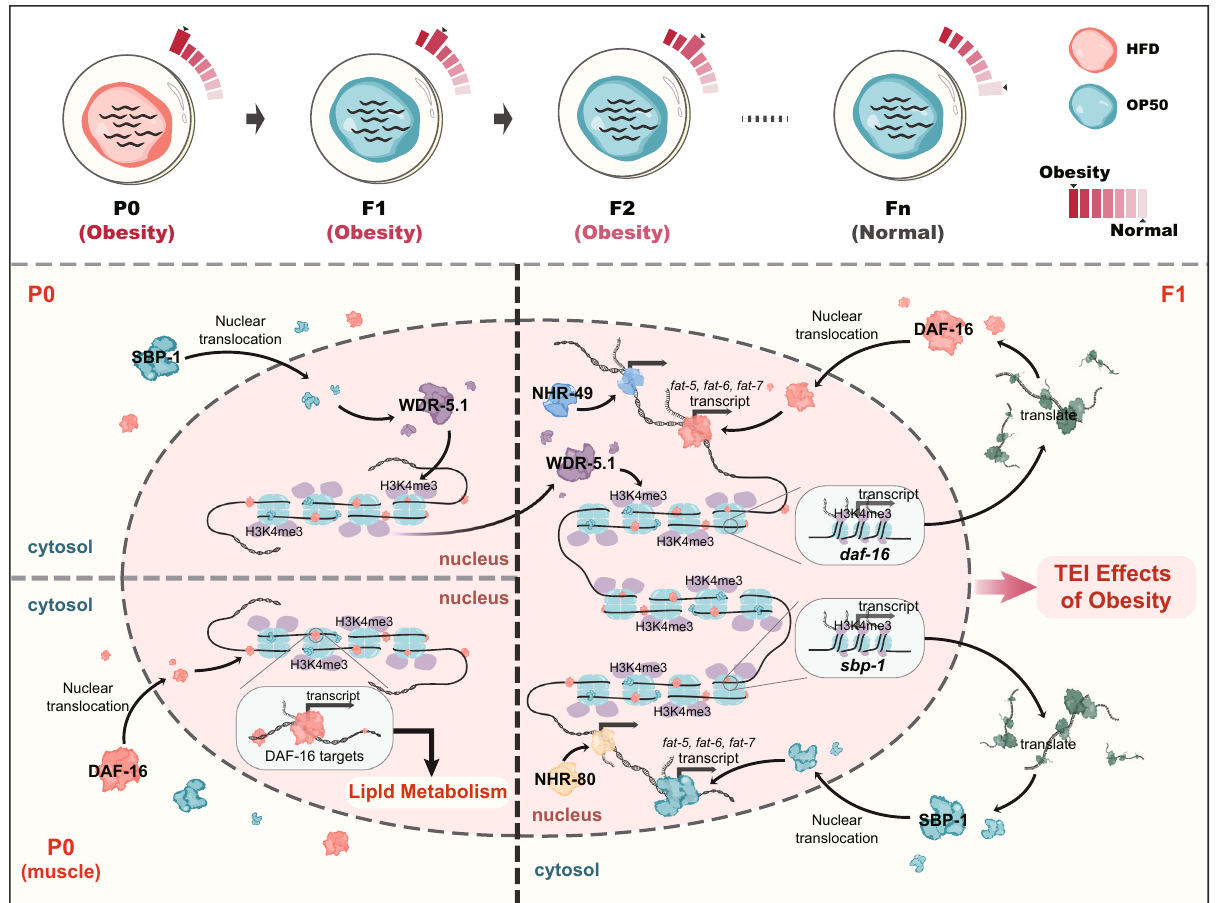
Fig. 6 Overview model of transgenerational inheritance in response to lipid accumulation induced by the HFD. HFD can induce a TEI phenotype of lipid accumulation. In worms fed with HFD, the stress of lipid accumulation in the parent promotes the activity of sbp-1 , daf-16 , nhr-49 , and nhr-80 . Among them, only sbp-1 is involved in regulating histone H3K4me3 modi fi cation in a wdr-5.1 -dependent manner and establishing the epigenetic marks in descendants. The upregulation of H3K4me3 modi fi cation promotes the recruitment and activation of daf-16 and sbp-1 ; simultaneously, the activation of daf-16 and sbp-1 might recruit nhr-49 or nhr-80 , which then synergistically induce the expression of fat-5, fat-6 and fat-7 to respond lipid metabolism, thereby completing the TEI of obesity